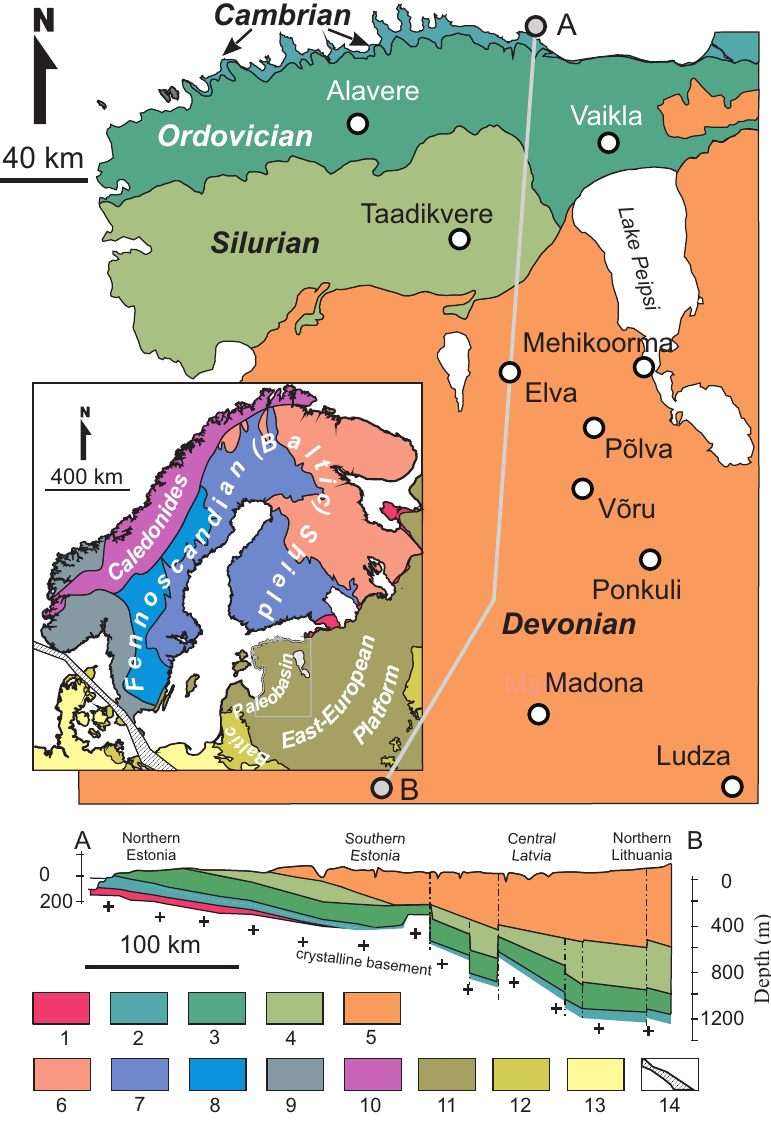
Fig. 1. Simplified geological map of Fennoscandia and the northern part of the Baltic Palaeobasin (BP) with locations of the studied drill core sections and geological profile through the northern part of the BP. 1, Neoproterozoic (Ediacaran); 2, Cambrian; 3, Ordovician; 4, Silurian; 5, Devonian; 6, Archaean Domain; 7, Svecofennian Domain; 8, Transscandinavian Belt; 9, Sveconorwegian Belt; 10, Caledonides; 11, Palaeozoic; 12, Mesozoic; 13, Cenozoic; 14, Tornquist